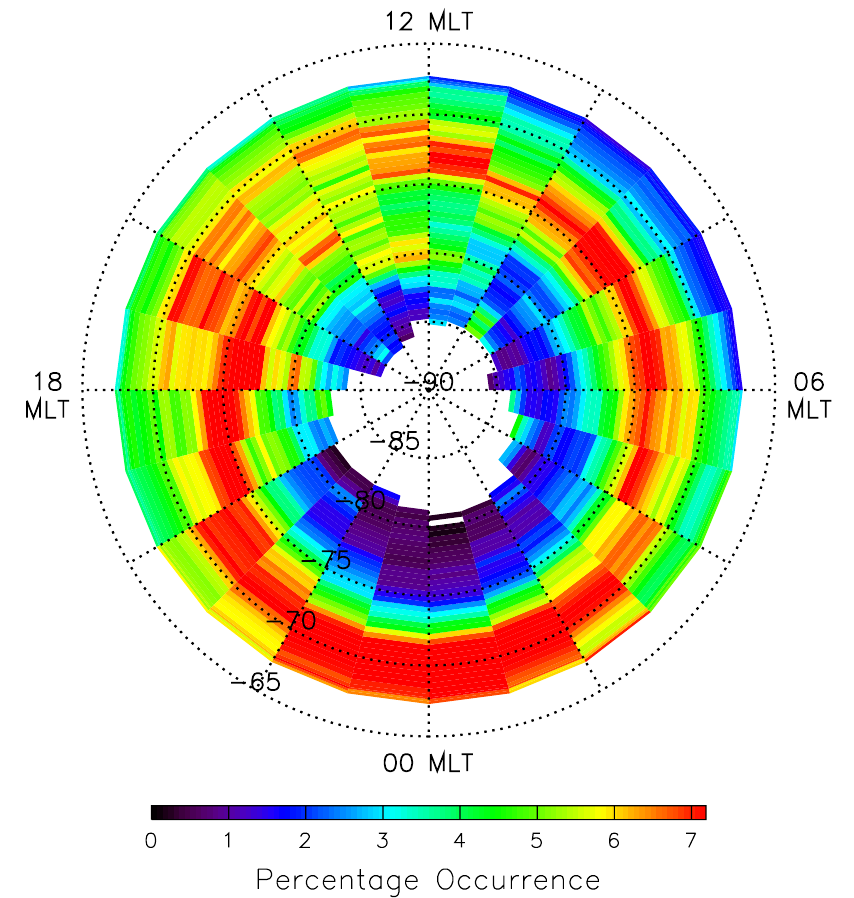
Fig. 12. The probability distribution of observed boundary locations determined within the 5-year Halley database using the C-F threshold technique, smoothed by the application of a 5-range gate moving